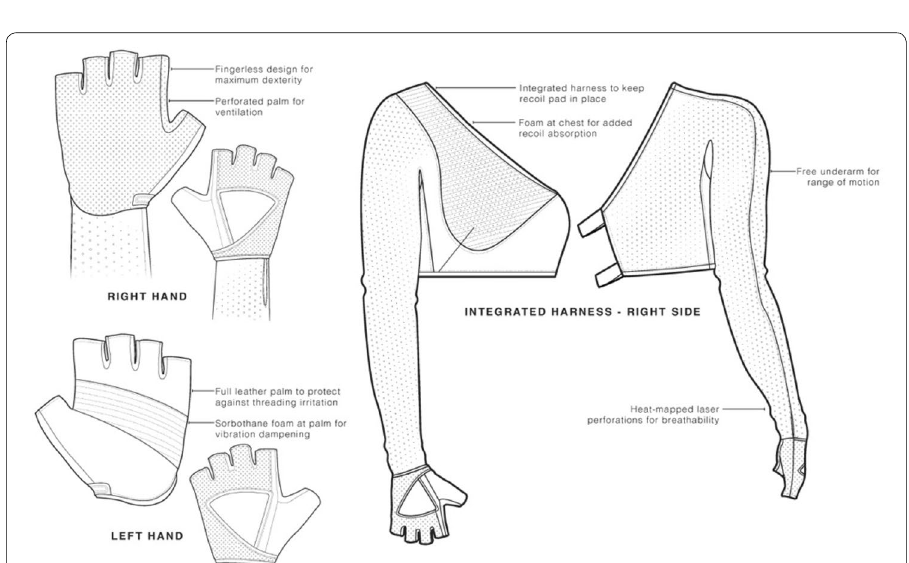
Fig. 19 Clay pigeon glove and harness product tech drawings (Echols